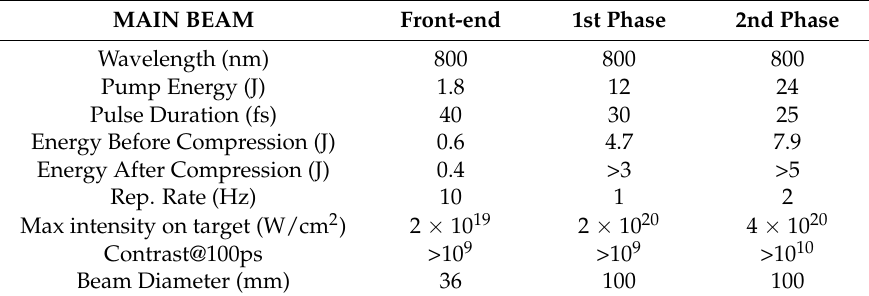
Table 1. Summary table of the ILIL-PW laser parameters including the front-end and the full system after the two-step facility upgrade.